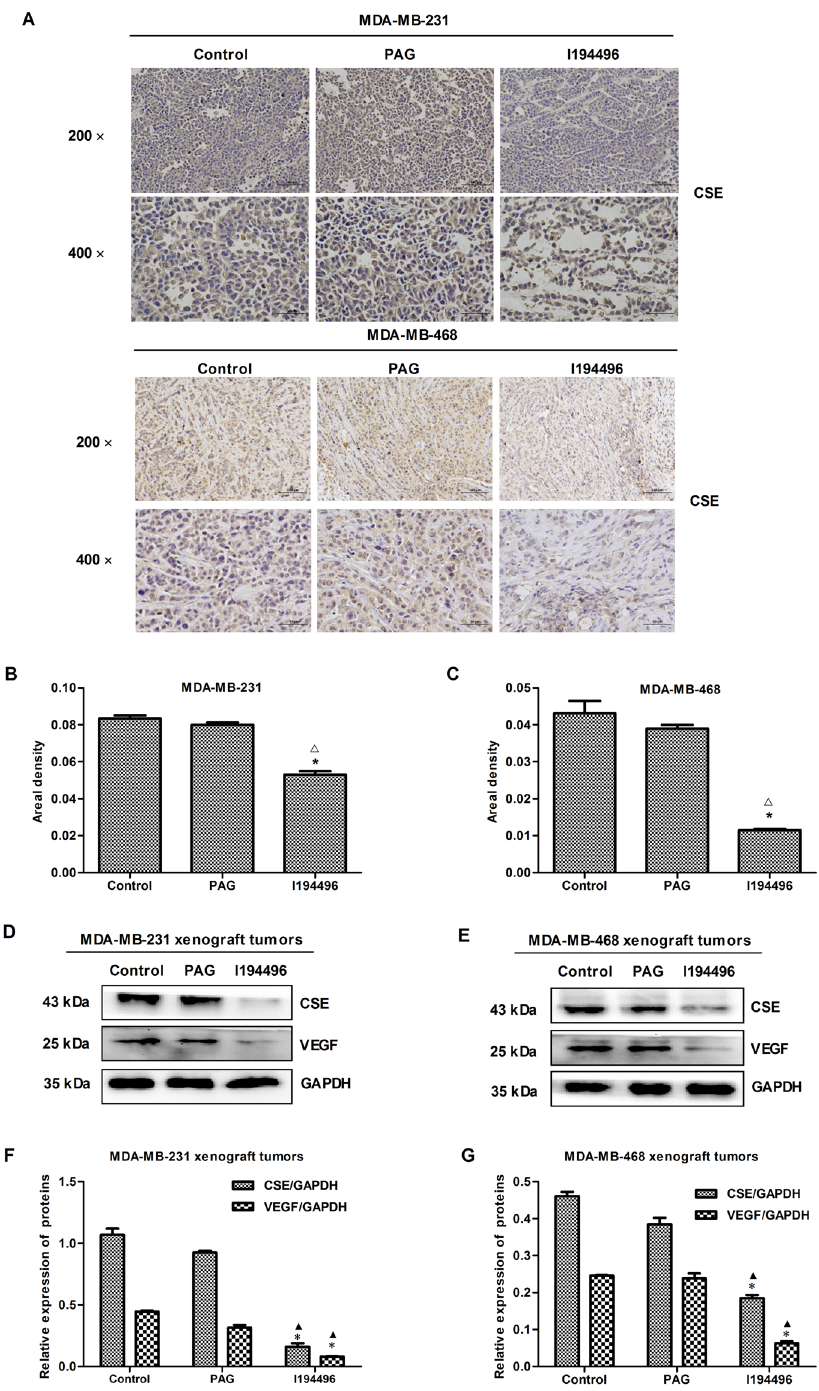
Figure 8. IHC and western blot assays of MDA-MB-231 and MDA-MB-468 xenograft tumors in nude mice. ( A ) Representive photographs of CSE staining in MDA-MB-231 and MDA-MB-468 xenograft tumors; original magnification ×200 and ×400. ( B , C ) CSE-positive expression level was calculated as areal density = IOD/AREA, where IOD represents positive cumulative optical density values and AREA represents the pixel area of the organization. Values are presented as mean ± SEM (n = 5); *P < 0.05 compared with the control group; △ P < 0.05 compared with PAG group. ( D , E ) CSE and VEGF expression analysis in MDA-MB-231 and MDA-MB-468 xenograft tumors. ( F , G ) The statistical analysis of CSE and VEGF expression level in MDA-MB-231 and MDA-MB-468 xenograft tumors; Values are presented as mean ± SEM (n = 5); *P < 0.05 compared with the control group; ▲ P < 0.05 compared with PAG